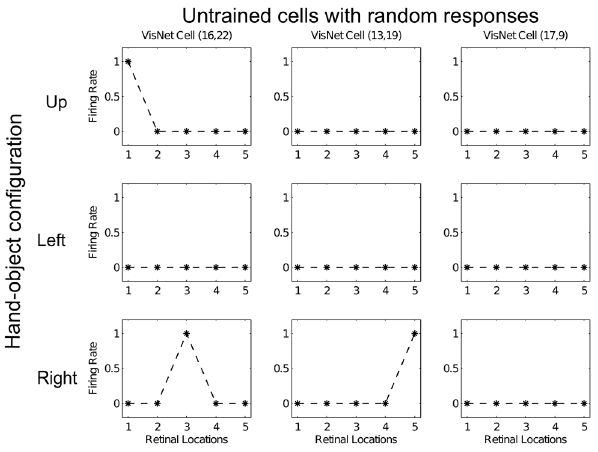
Figure 3. Response profiles of three neurons in the top (fourth) layer of VisNet before training. Each of the three columns shows the firing responses of a particular cell. Each row shows the responses of the cells to one of the three hand-object configurations over all five retinal locations shown along the abscissae. Top row: visual object is shown in the ‘Up’ location with respect to the hand. Middle row: visual object is shown in the ‘Left’ location with respect to the hand. Bottom row: visual object is shown in the ‘Right’ location with respect to the hand. It can be seen that each of the three cells initially responds randomly to each of the hand-object configurations over the different retinal locations.